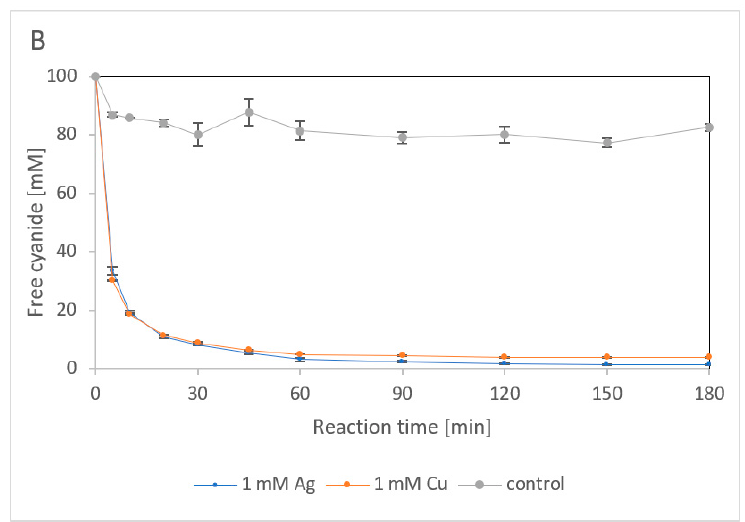
Figure 7. Biocatalyzed degradation of 100 mM free cyanide (fCN) in 100 mM glycine/NaOH, pH 9.0, by ( A ) 14, 20 or 30 µg enzyme/mL, and ( B ) 14 µg enzyme/mL in the presence of 1 mM AgNO 3 or 1 mM CuSO 4 . Residual fCN concentration was determined by picric acid method. The enzyme and the metal salts were omitted from the control.